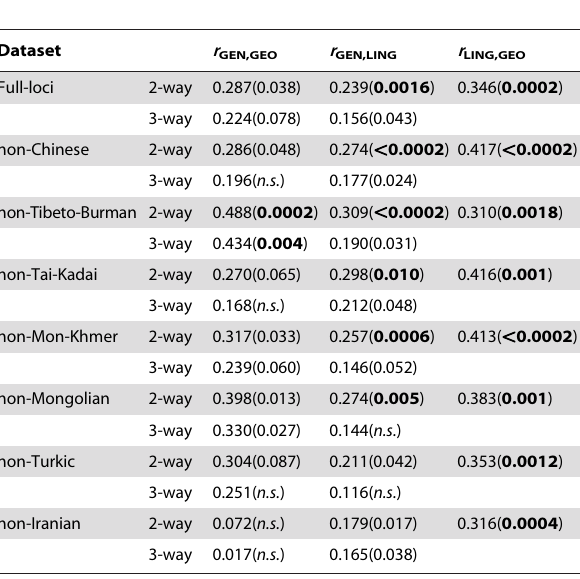
Table 3. Correlation coefficients among genetic (GEN), geographic (GEO), and linguistic (LING)